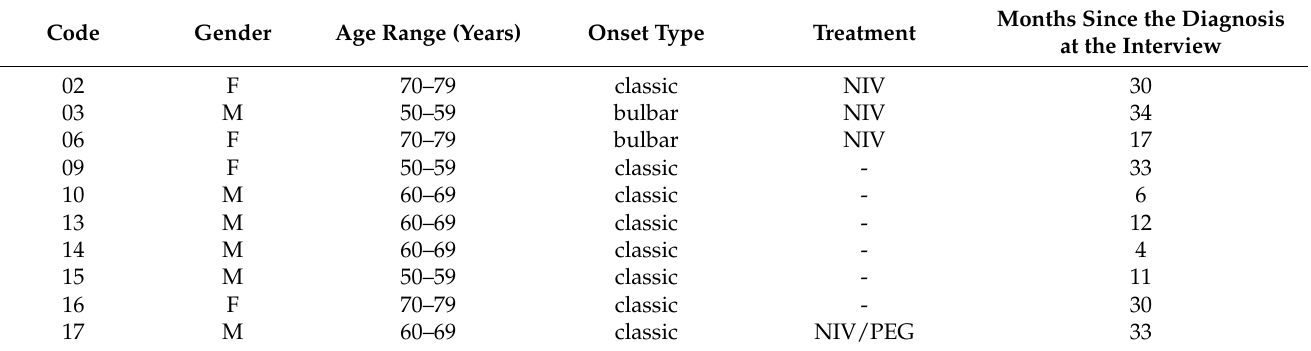
Table 2. Characteristics of individuals with ALS (n = 10).